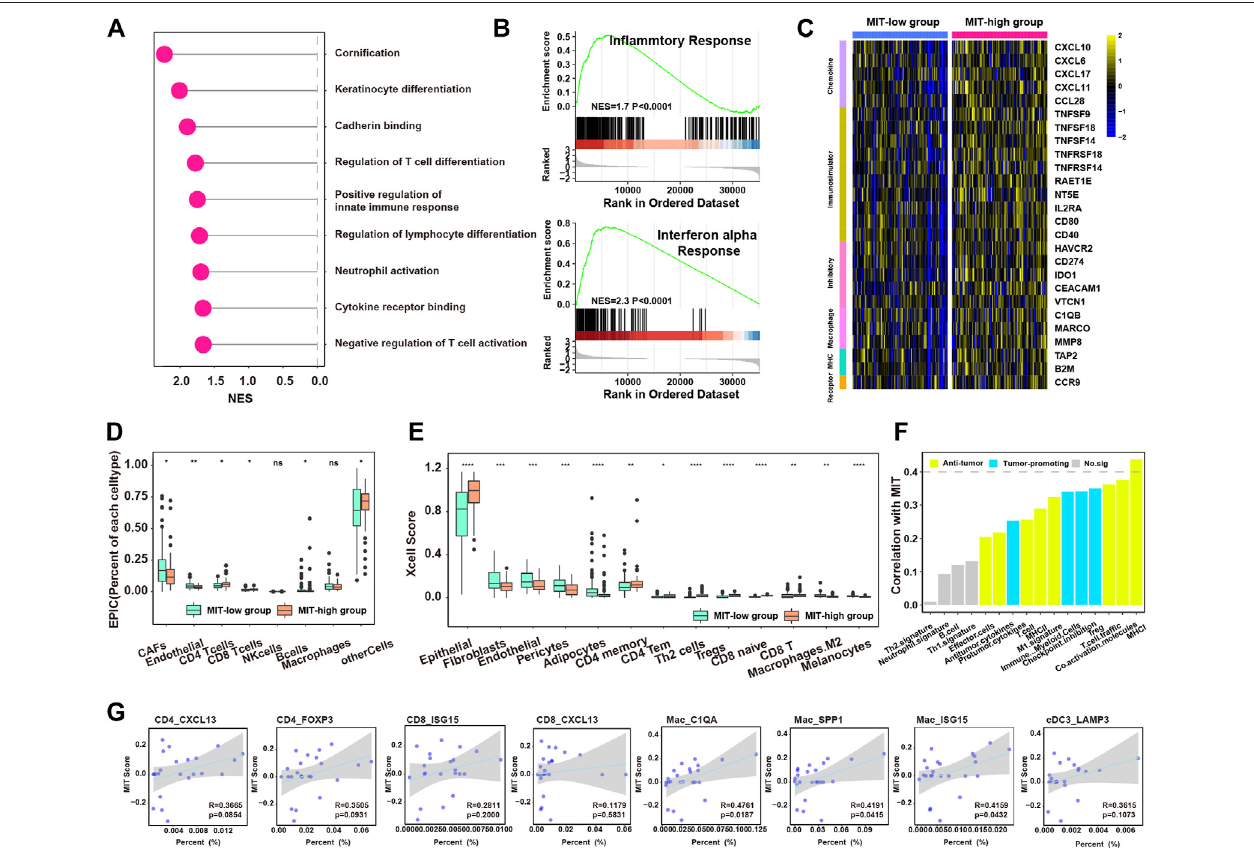
FIGURE 4 | MIT score is associated with tumor-promoting immune microenvironment. (A) , enriched pathways for the upregulated genes in MIT high group comparedtoMITlowgroup. (B) , thetwoenriched immunehallmark pathways in MIThigh groupcomparedtoMITlowgroup derivedfrom GSEA analysis. (C) ,heatmap showing the differential expression of immune-associated genes between MIT high and low group. The color bar represents the level of expression (Standardized by TPM). (D) ,boxplotshowingthedifferenceinproportionsofimmunecelltypes(derivedfromEPICalgorithm)betweenMIThighandlowgroups.*, p -value < 0.05;**, p -value < 0.01; ***, p -value < 0.001 from two-sided paired Student ’ s t-test. (E) , boxplot showing the difference in proportions of immune cell types (derived from xCell algorithm) between MIT high and low groups. *, p -value < 0.05; **, p -value < 0.01; ***, p -value < 0.001 from two-sided paired Student ’ s t-test. (F) , barplot showing the correlationbetweentheMITscoreandfunctionalgeneexpressionsignaturesinPDAC. (G) ,Thecorrelationbetweentheproportionoftumor-promotingimmuneclusters (CD4_CXCL13, CD4_FOXP3, CD8_ISG15, CD8_CXCL13, Mac_C1QA, Mac_SPP1, Mac_ISG15 and cDC3_LAMP3) and MIT